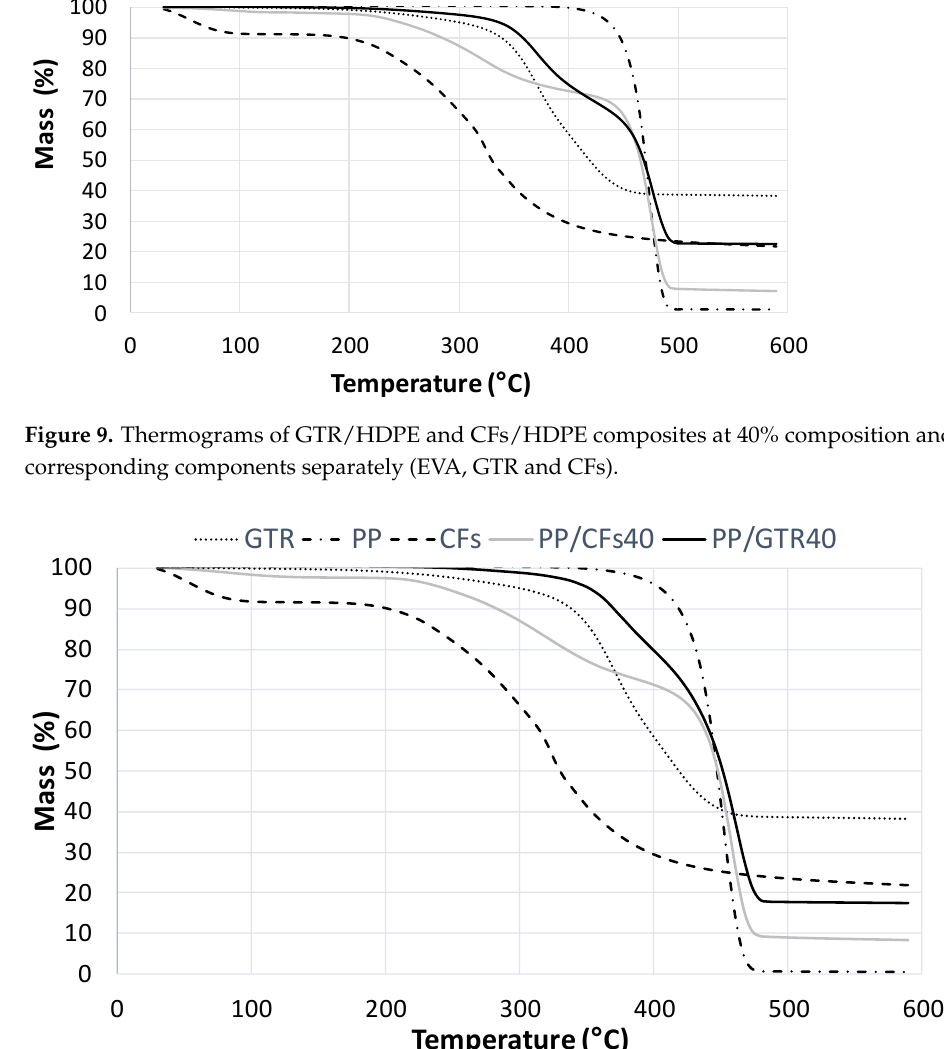
Figure 11. α values for HDPE and GTR/HDPE and CFs/HDPE composites at 40% composition.